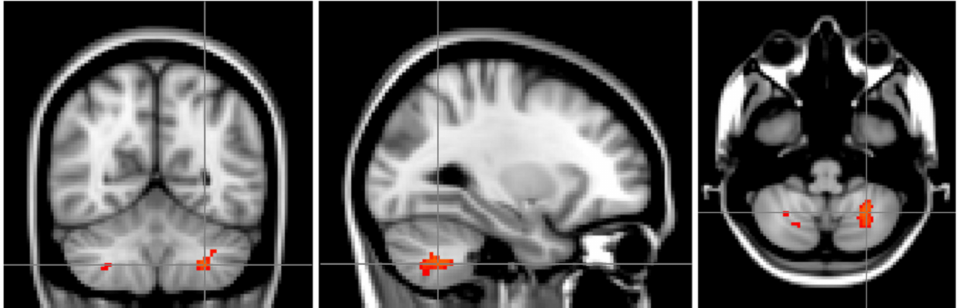
Figure 1. SLE patients had lower grey matter probability values in the left (and to a lesser extent the right) VIIIa area of the cerebellum when compared to controls. The images are oriented as seen from the front, so left above is right and vice versa. The images depict a study specific template brain with the effects between the groups (NeuroPsychiatric Systemic Lupus Erythematosus (NPSLE) and non-NPSLE versus controls) superimposed.